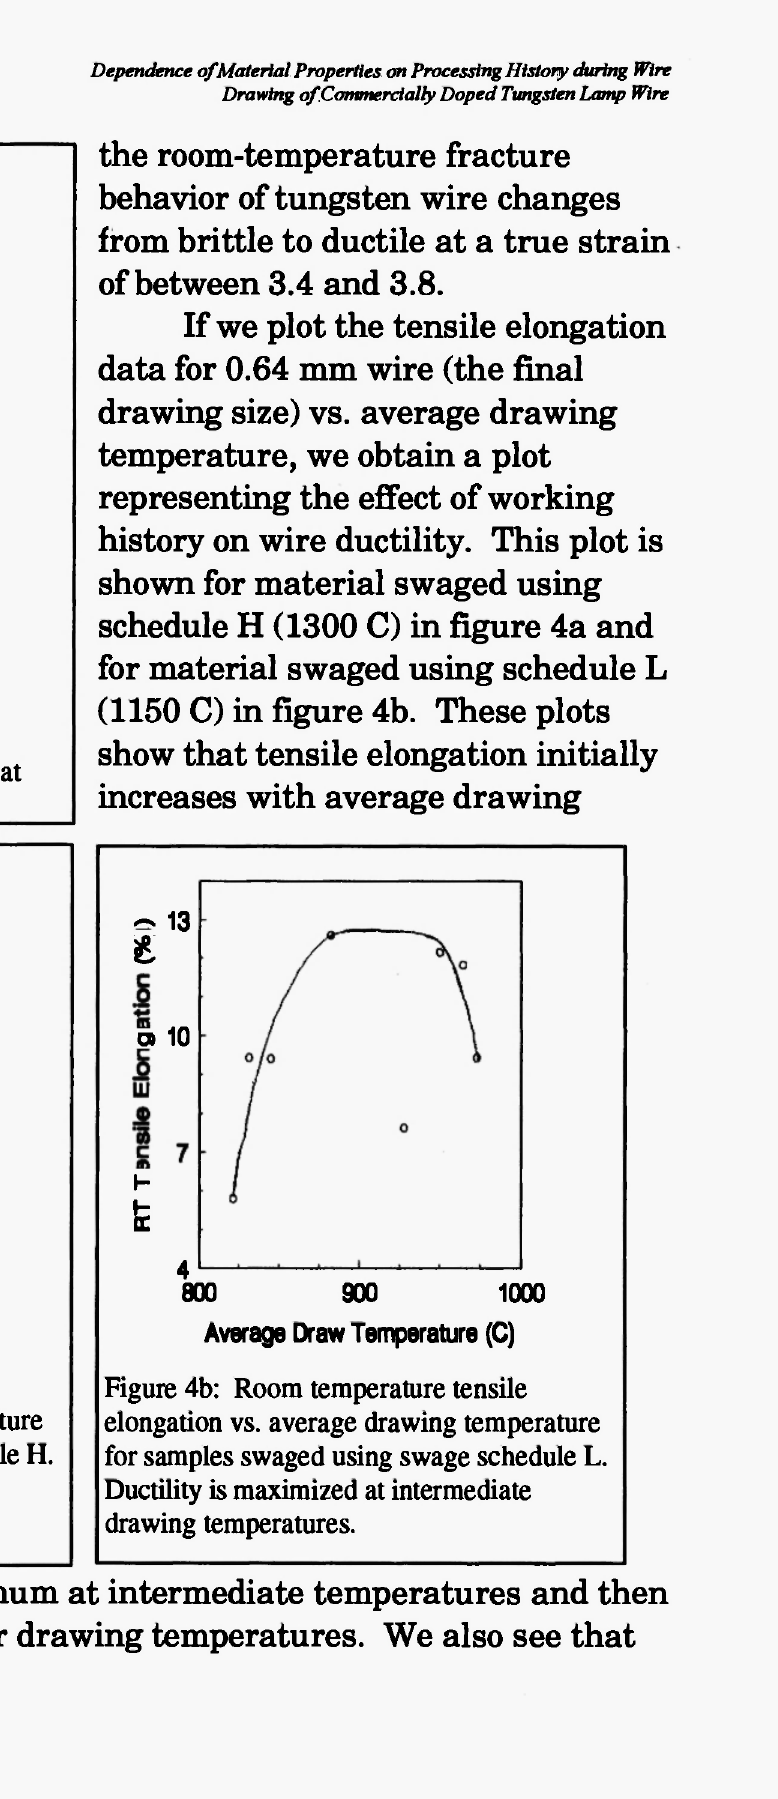
Figure 4a: Room temperature tensile elongation vs. average drawing temperature for samples swaged using swage schedule H. Ductility is maximized at intermediate average drawing temperatures.